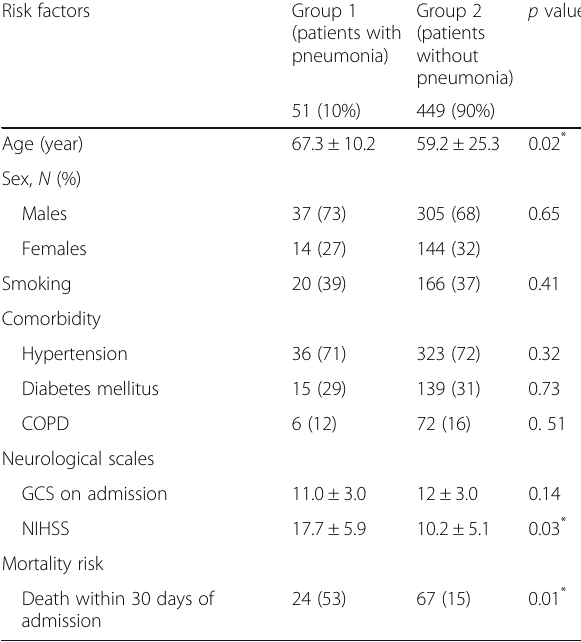
the demographic data, comorbidity and neurological scales as well as mortality risk Risk factors Group 1 (patients